Question: Based on the figure, does the quantity rise or fall?
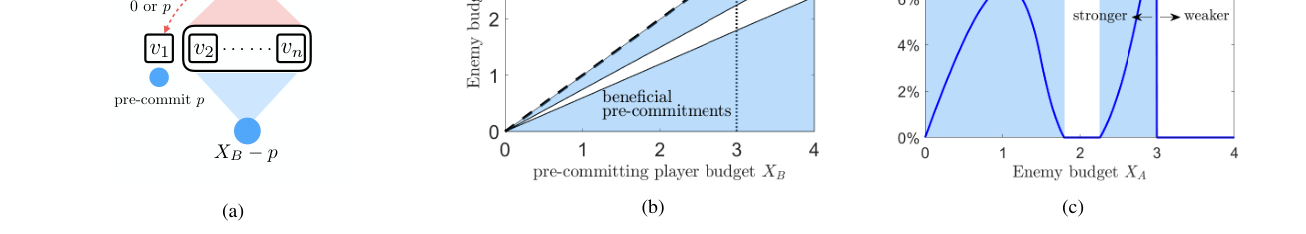
Answer: increasing